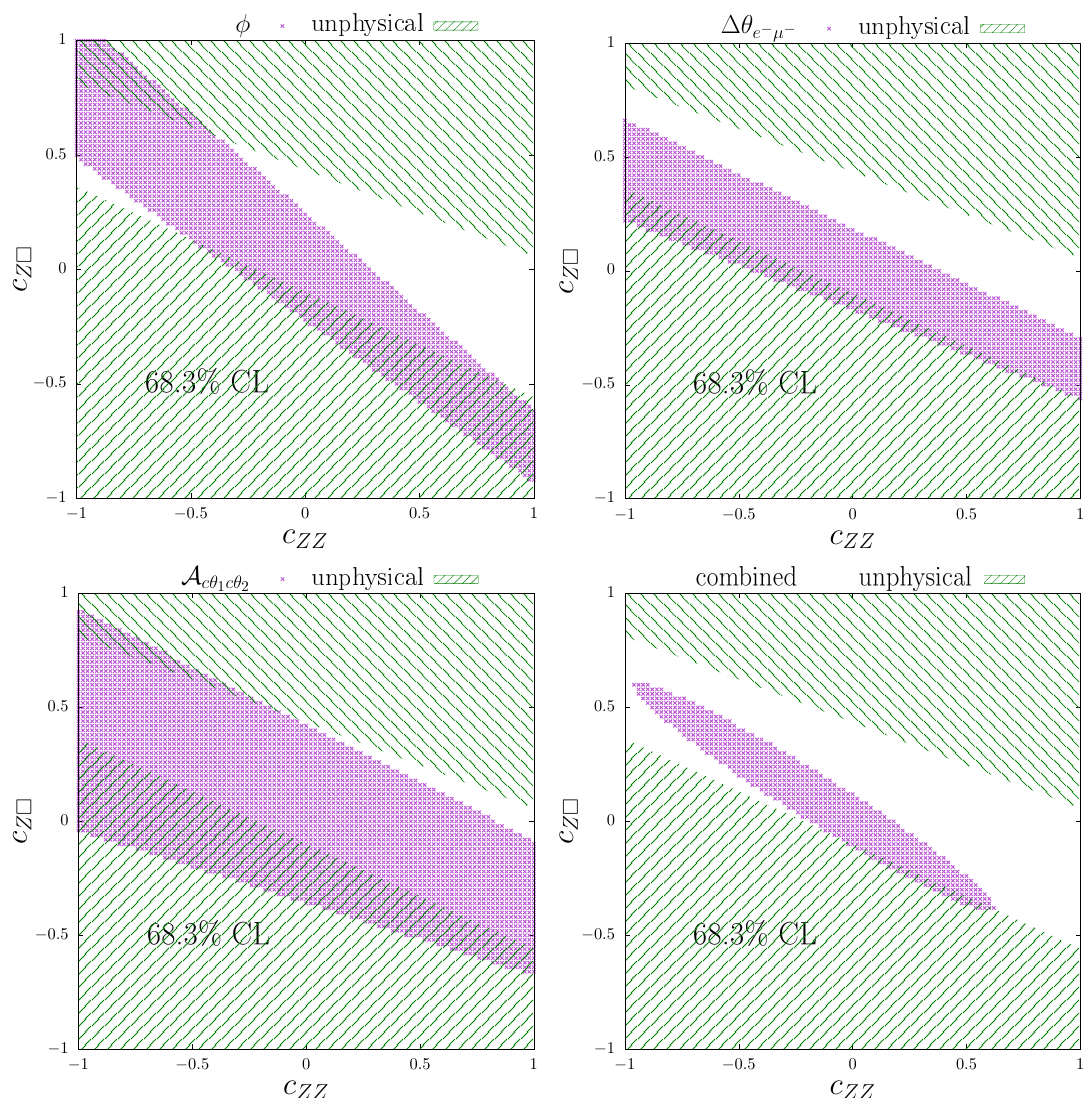
Figure 6. Contour plot at 68.3% CL for the angles (cid:30) , (cid:1) (cid:18) left panel). In the lower-right panel we display the contour plot derived from the (cid:31) 2 The contour plots are derived according to the procedure detailed in section 4.3.1. The green regions correspond to values of the e(cid:11)ective coe(cid:14)cients leading one of the quantities in eqs. (C.1){(C.3) to negative